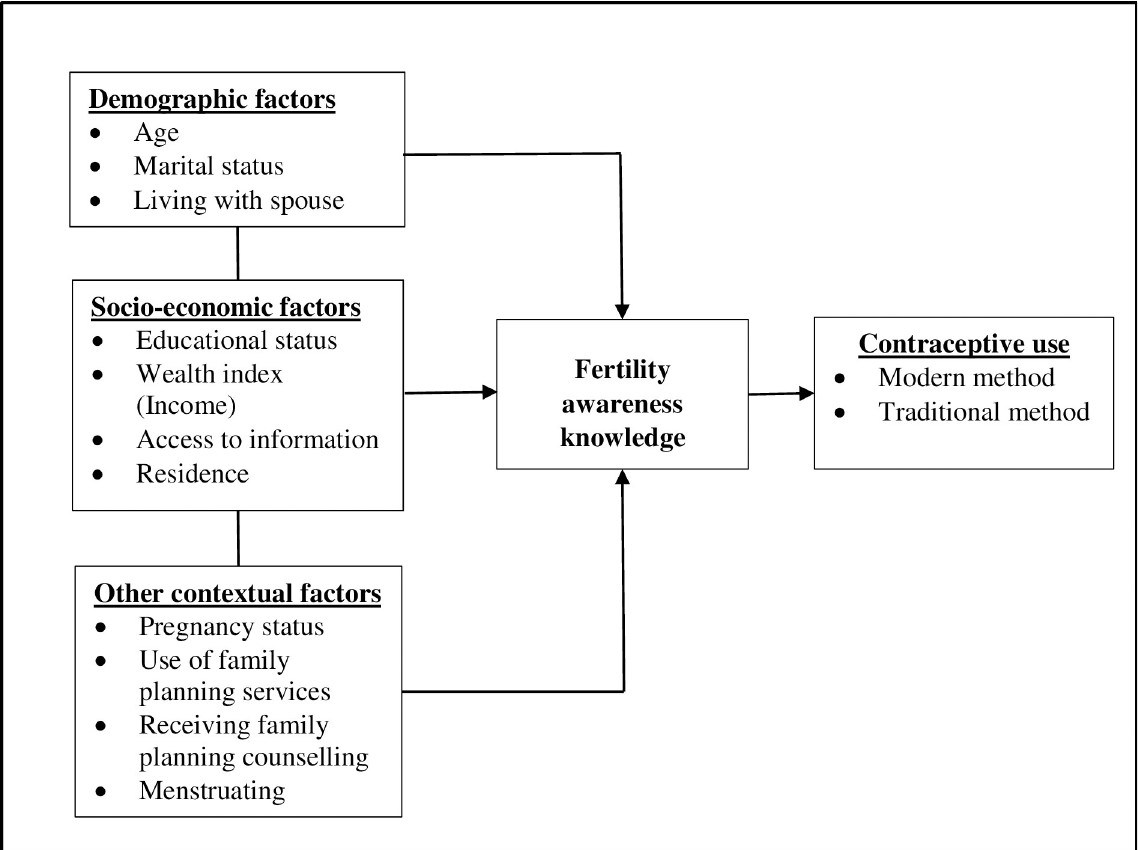
Fig 1. Conceptual framework for factors associated with fertility awareness knowledge among young women in sub-Saharan Africa.